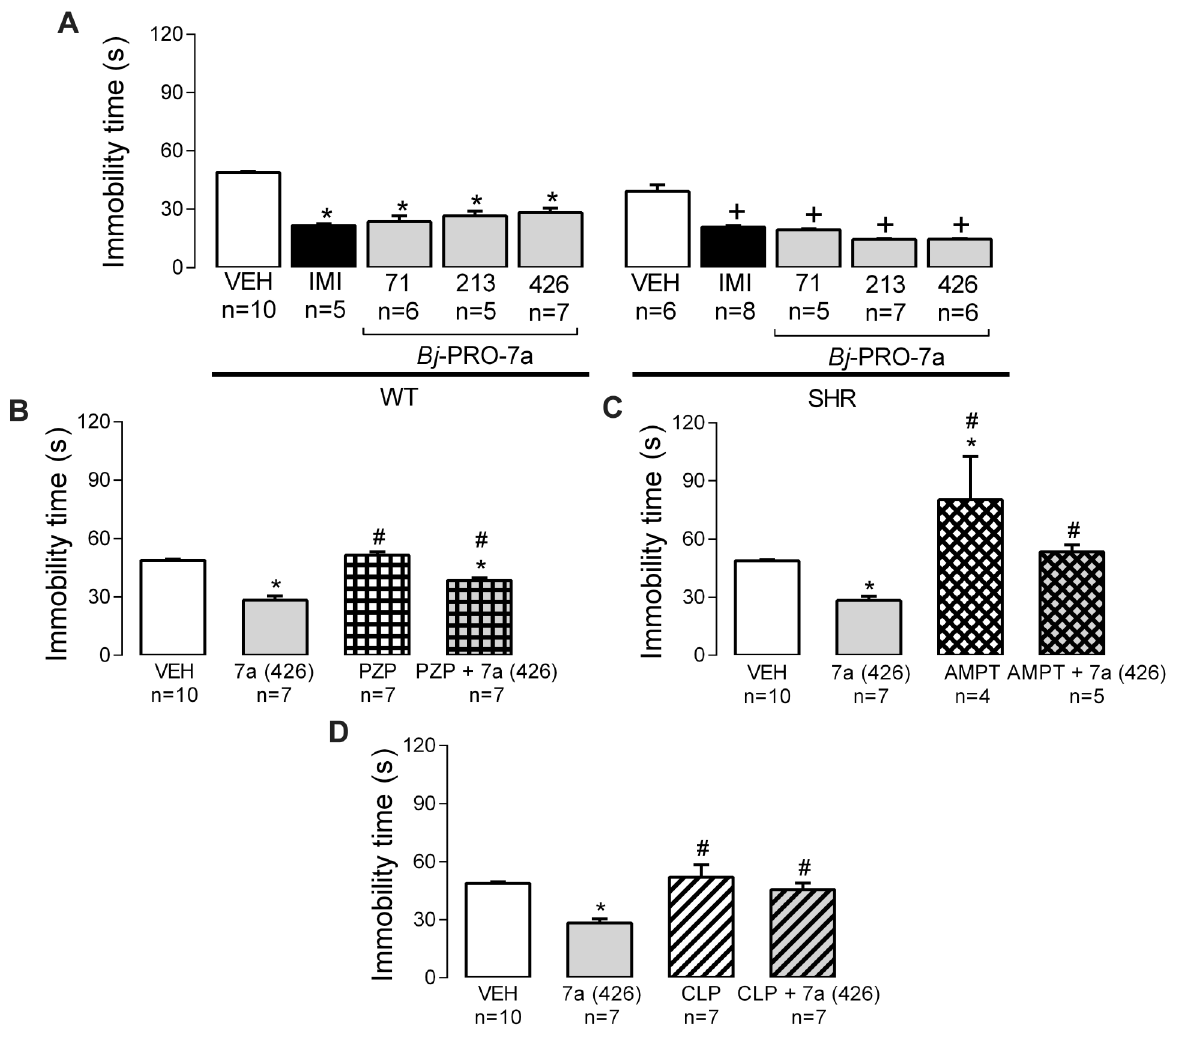
Figure 9. Antidepressant-like effects measured by the immobility time in the forced swimming test. A , Effects of Bj-PRO-7a on antidepressant-like behaviors in Wistar (WT) and spontaneously hypertensive rats (SHR). B , Contribution of muscarinic receptor subtype 1 (as revealed by the antagonism with pirenzepine - PZP) to the anti-depressant-like effects evoked Bj-PRO-7a. C , Contribution of catecholaminergic paths (as revealed by the depleter a -methyl-DL-tyrosine: AMPT) to the effects evoked by Bj-PRO-7a. D , Contribution of dopaminergic receptors (as revealed by the antagonism with chlorpromazine - CLP) to the effects evoked by Bj-PRO-7a. Experimental groups: VEH: vehicle (0.9% NaCl); IMI: imipramine (15 mg/kg); 7a: Bj-PRO-7a (71, 213, or 426 nmol/kg); PZP: pirenzepine (852 nmol/kg); PZP + 7a(426): co-administration of PZP and Bj-PRO-7a (426 nmol/kg); AMPT (200 mg/kg); AMPT + 7a(426): co- administration of AMPT and Bj-PRO-7a (426 nmol/kg); CLP: CLP (2 mg/kg); CLP + 7a (426): co-administration of CLP and Bj-PRO-7a (426 nmol/kg). Data are reported as means ± SE. *P o 0.05 vs VEH WT; + P o 0.05 vs VEH SHR; # P o 0.05 vs 7a (426) [two-way analysis of variance followed by Bonferroni ’ s test (panel A ) and one-way analysis of variance followed by Fisher ’ s post hoc test (panels B – D